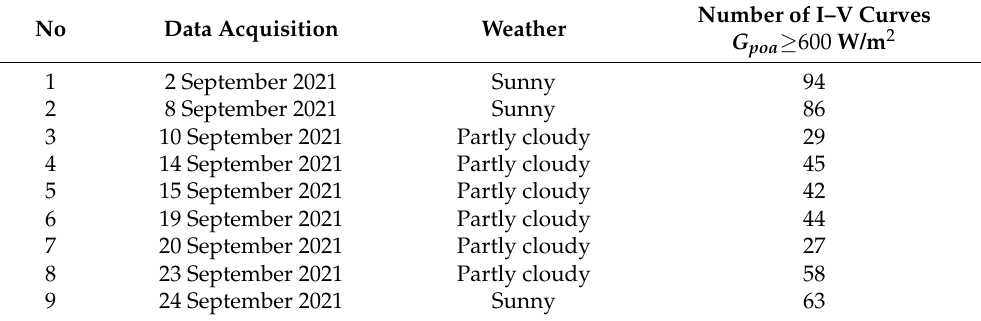
Table 3. Data used for the training stage.